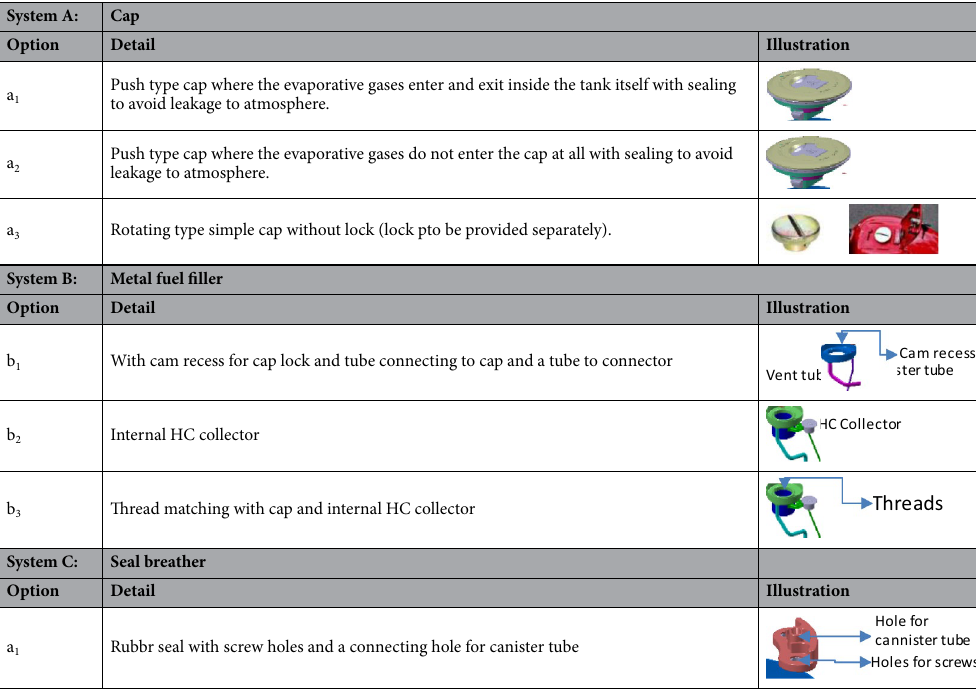
Table 10. Design options for components of fuel-cap.